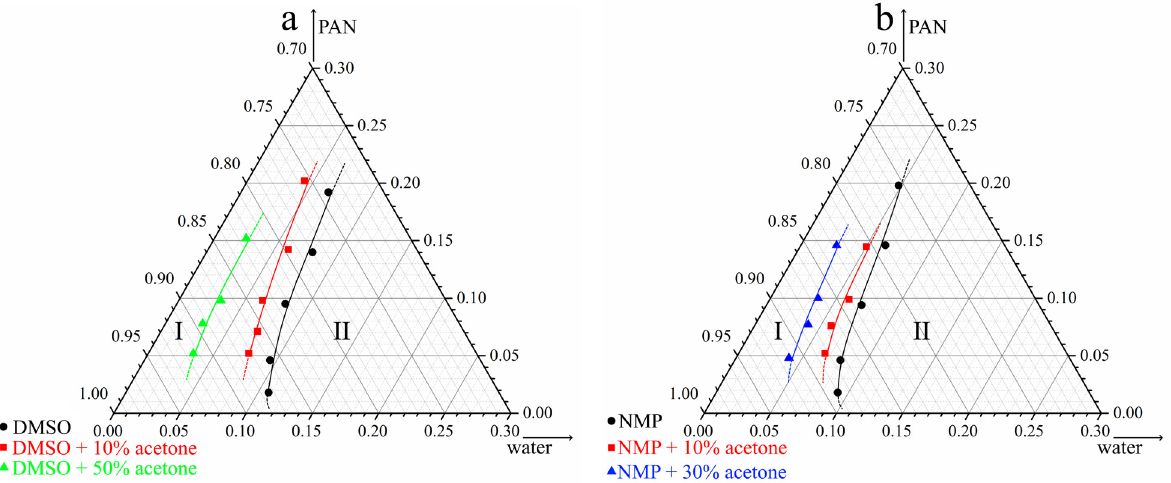
Figure 3. Ternary phase diagrams of mixtures PAN—DMSO (DMSO + acetone)—water ( a ) and PAN—NMP (NMP + acetone)—water ( b ).